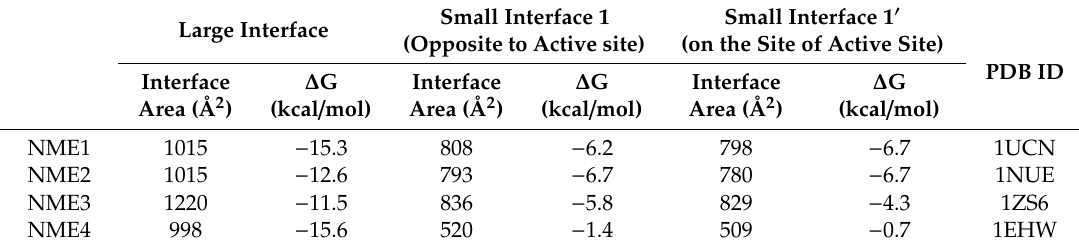
Table 2. Interface area and Gibbs free energy of subunit interfaces of human